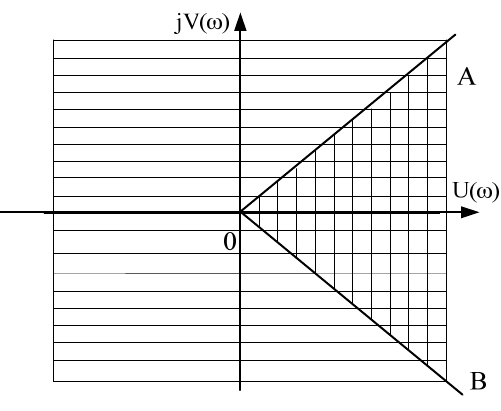
Figure 32. Polynomial basis j 1/2 —sector (cid:4672) 𝝅 are out of the sector, the system is stable.